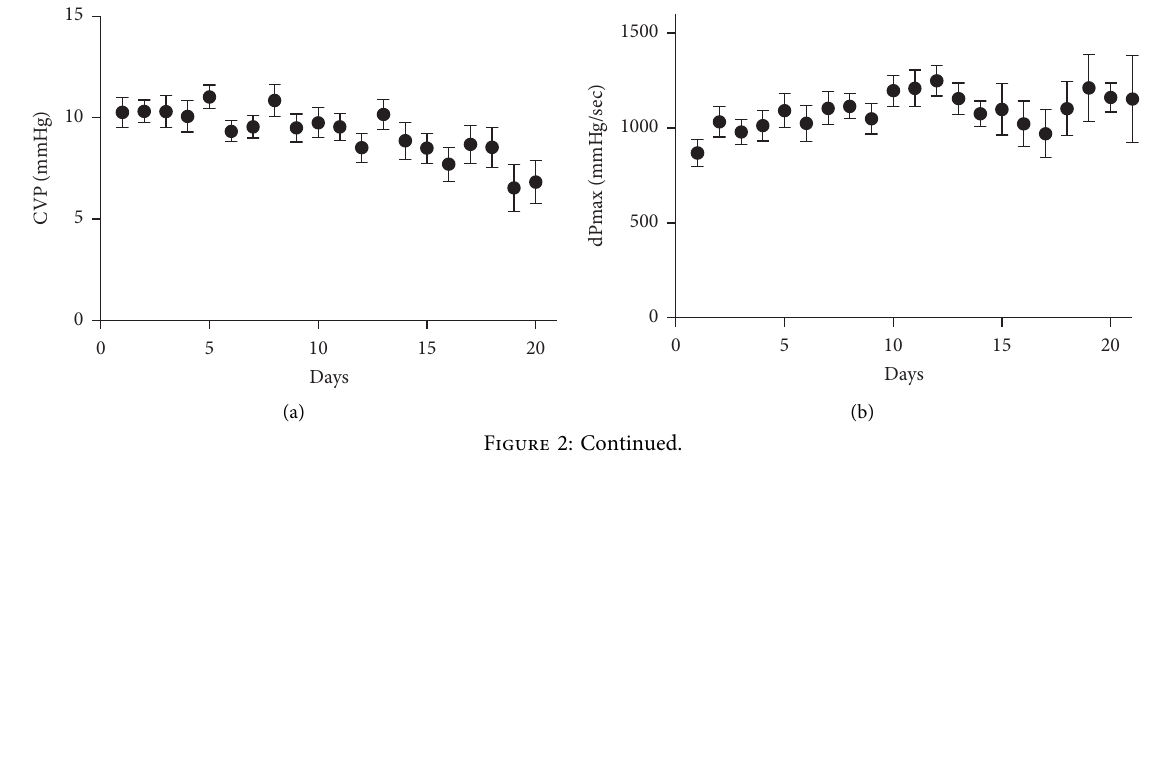
i : stroke volume